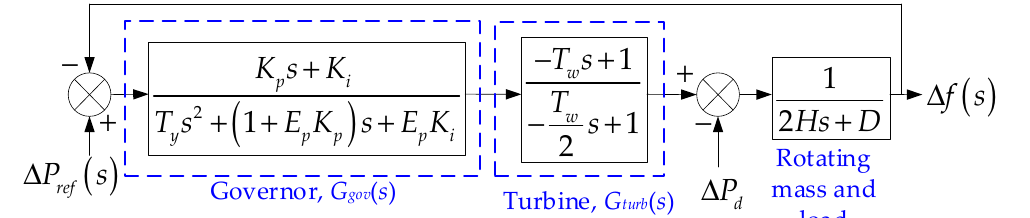
Figure 3. Block diagram of a single control area: The main controllers involved in the SFR are represented in the control area. Δ P d represents the system frequency disturbance (4800 MW). K p = 1.6, K i = 0.175, E p = 0.133, T y = 0.2 s, T w = 1.01, D = 0.517 (data modified from [34]).